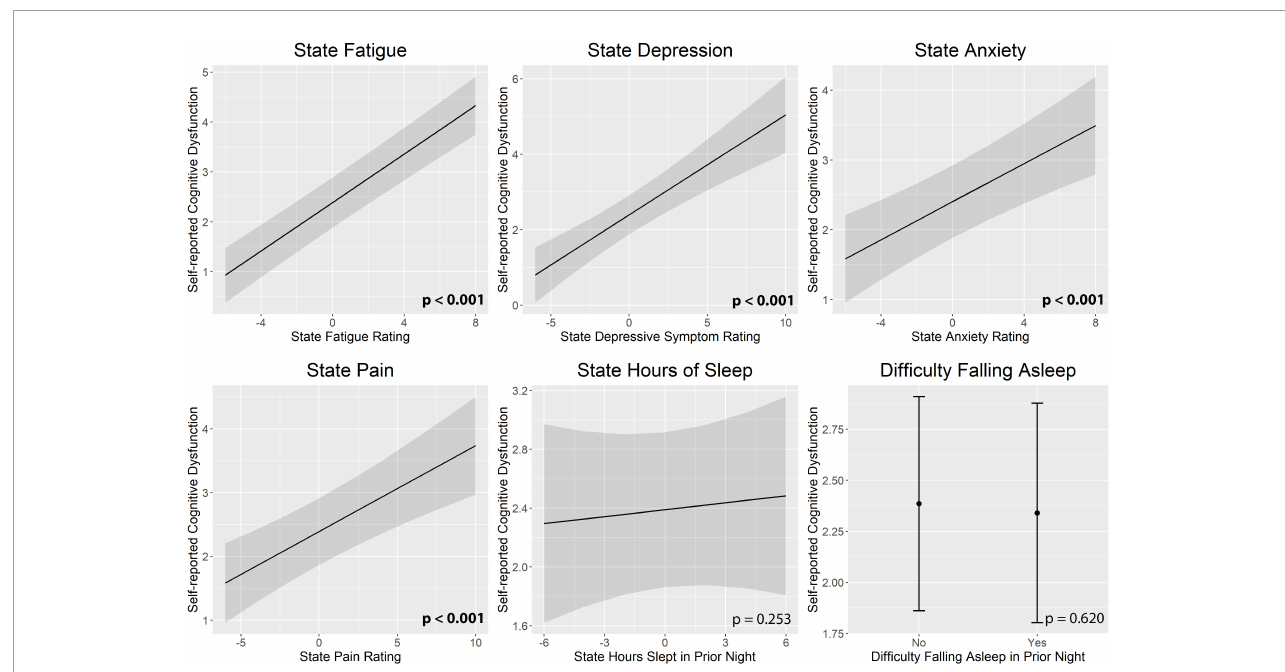
FIGURE4 Real-time associations between non-cognitive symptom ratings and self-reported cognitive dysfunction. State fatigue, depressive symptoms, anxiety, and pain were all significant predictors of self-reported cognitive dysfunction. State and trait aspects of each symptom was tested together in the same model; plots show the marginal effects of the state variables. All models included subject and day number as random intercepts and state and trait depressive symptoms as fixed effects. Error bands represent 95% confidence